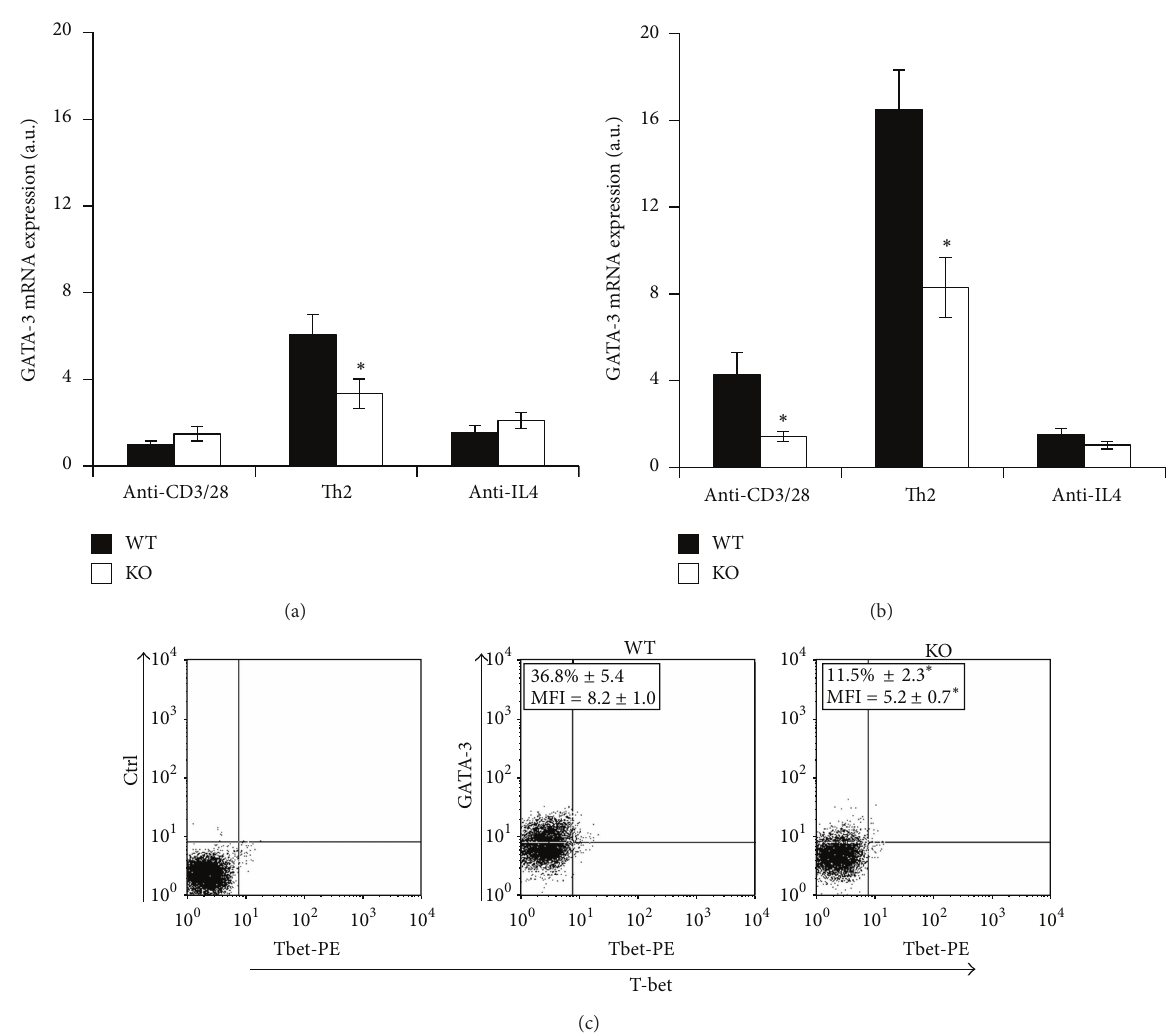
Figure 2: PARP-1 deficient cells express GATA-3 at lower levels than WT cells. Na¨ıve CD4 T cells from wild type (WT, filled symbols) and PARP-1KO (KO, unfilled symbols) mice were stimulated with anti-CD3 and anti-CD28 mAbs alone or together with either IL-4 and neutralizinganti-IFN- 𝛾 mAb(Th2-polarzingconditions)oranti-IL4neutralizingmAb(anti-IL4).GATA-3mRNAexpressionwasassessedby reverse transcription and real time PCR after 24 (a) and 72 (b) hours of stimulation. Results, normalized on the housekeeping gene (GAPDH) mRNA level, are referred to the GATA-3 mRNA level in WT cells stimulated for 24 hrs and expressed as arbitrary units. Values represent means ± S.E. from three independent experiments. (c) After 72 hours of stimulation with anti-CD3, rCD86 cells and IL-4 (and anti-IFN- 𝛾 ) cells were analyzed by flow cytometry. Representative dot plots are shown. The indicated percentage of GATA-3-expressing cells and mean fluorescence intensity (MFI) for GATA-3 staining are means ( ± S.E.) from three independent experiments. ∗ 𝑃 < 0.05 for KO versus WT cells, where indicated in (a), (b), and